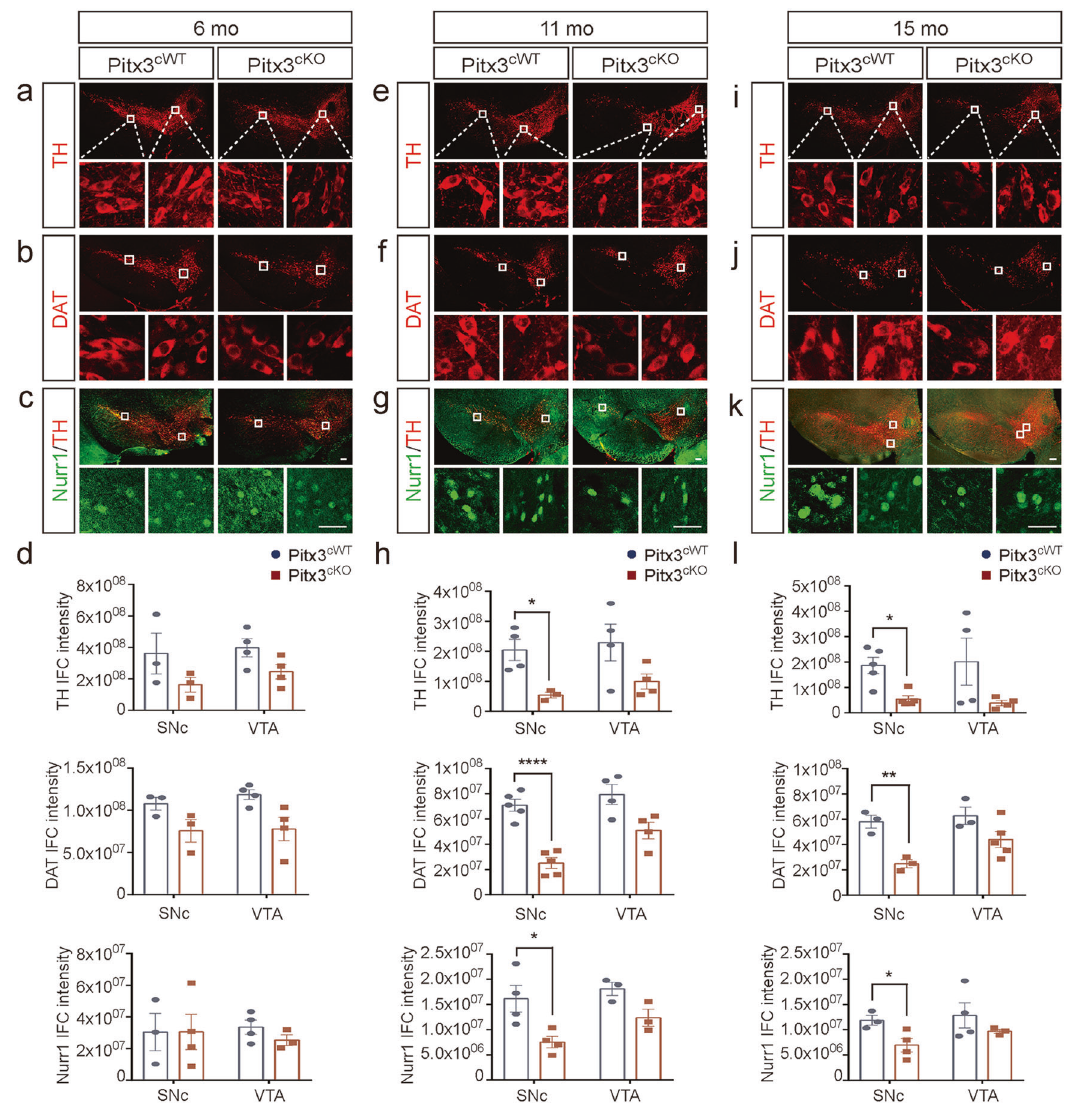
Fig. 6 Expression analysis of mdDA neuronal markers in Pitx3 cKO mice. The IFC staining of TH ( a , e , i ), DAT ( b , f , j ) and the IFC co-staining of Nurr1 and TH ( c , g , k ) were presented in the SNc and VTA from 6-, 11-, and 15-month-old Pitx3 cWT and Pitx3 cKO mice (scale bar: 100 μ m; high- magni fi cation, 25 μ m). d , h , l Quanti fi cation of TH, DAT, and Nurr1 IFC intensity in the SNc and VTA from 6-, 11-, and 15-month-old Pitx3 cWT and Pitx3 cKO mice ( N = 3 – 5 mice per genotype). Unpaired t -test, * p = 0.0164 (TH, 11 months for SNc); **** p < 0.0001 (DAT, 11 months for SNc); * p = 0.0248 (Nurr1, 11 months for SNc); ** p = 0.0051 (DAT, 15 months for SNc); and * p = 0.0395 (Nurr1, 15 months for SNc); Mann – Whitney test, * p = 0.0159 (TH, 15 months for